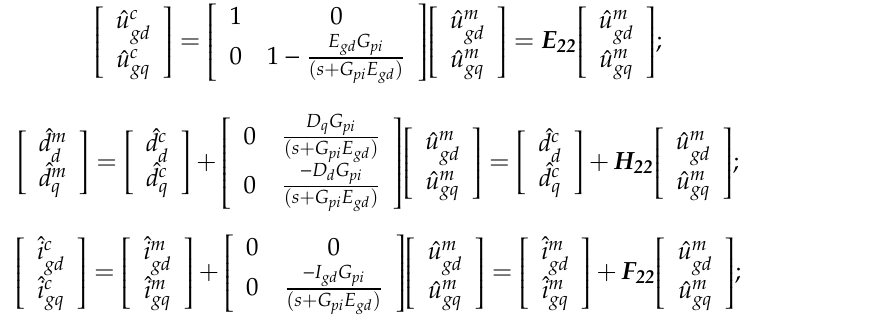
Figure 11. The small-signal transfer diagram of the GSC control excepting PLL. The angular relationship between the GSC circuit module and the GSC control module with PLL is displayed in Figure 12. From Figures 9 and 12, a transfer diagram of the GSC control system with PLL can be drawn in Figure 13 by using the small-signal transfer models of the GSC control system described by Equations (34)–(36).